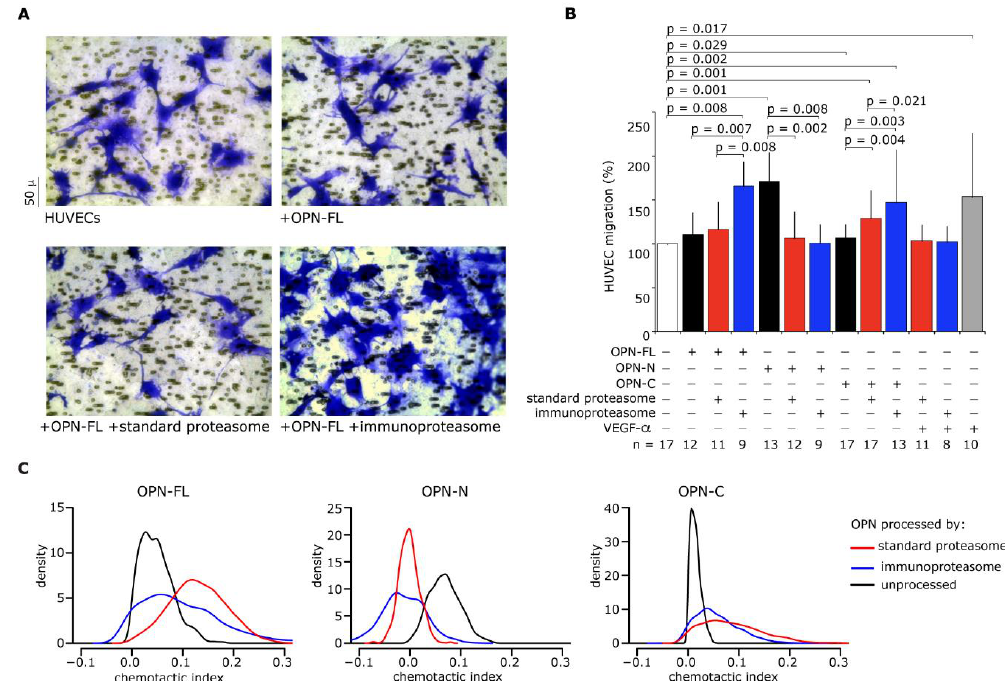
Figure 3. Extracellular immunoproteasomes enhance human umbilical vein endothelial cells (HUVEC) migration more than standard proteasomes through the processing of OPN-FL and OPN- C. ( A ) Images of migrated HUVECs (stained by crystal violet) treated with OPN-FL ± 20S standard- or immuno-proteasomes in a representative Boyden chamber migration assay of 8 – 17 independent experiments. ( B ) Effect of OPNs (OPN-FL, OPN-N, and OPN-C) ± 20S standard- or immuno- proteasomes, and VEGF- as positive control, on the HUVEC chemotaxis. Values are the percentage of treated versus untreated cells that migrated after 3 h and are the mean and SD of independent experiments (n = 8 – 17). Wilcoxon tests for paired samples p < 0.05 are shown. ( C ) Chemotactic indices for OPNs and their derived fragments generated by standard- and immuno-proteasomes, respectively. Chemotactic indices are estimated from cell migration experiments with HUVECs.